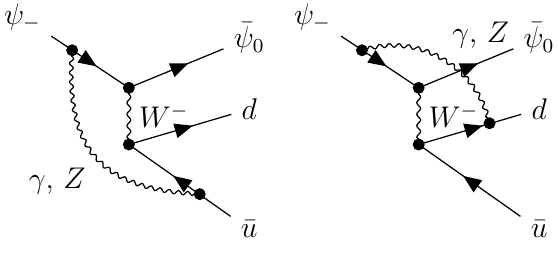
Figure 4 . The box contributions to the Wino decay into the free quarks in the electroweak